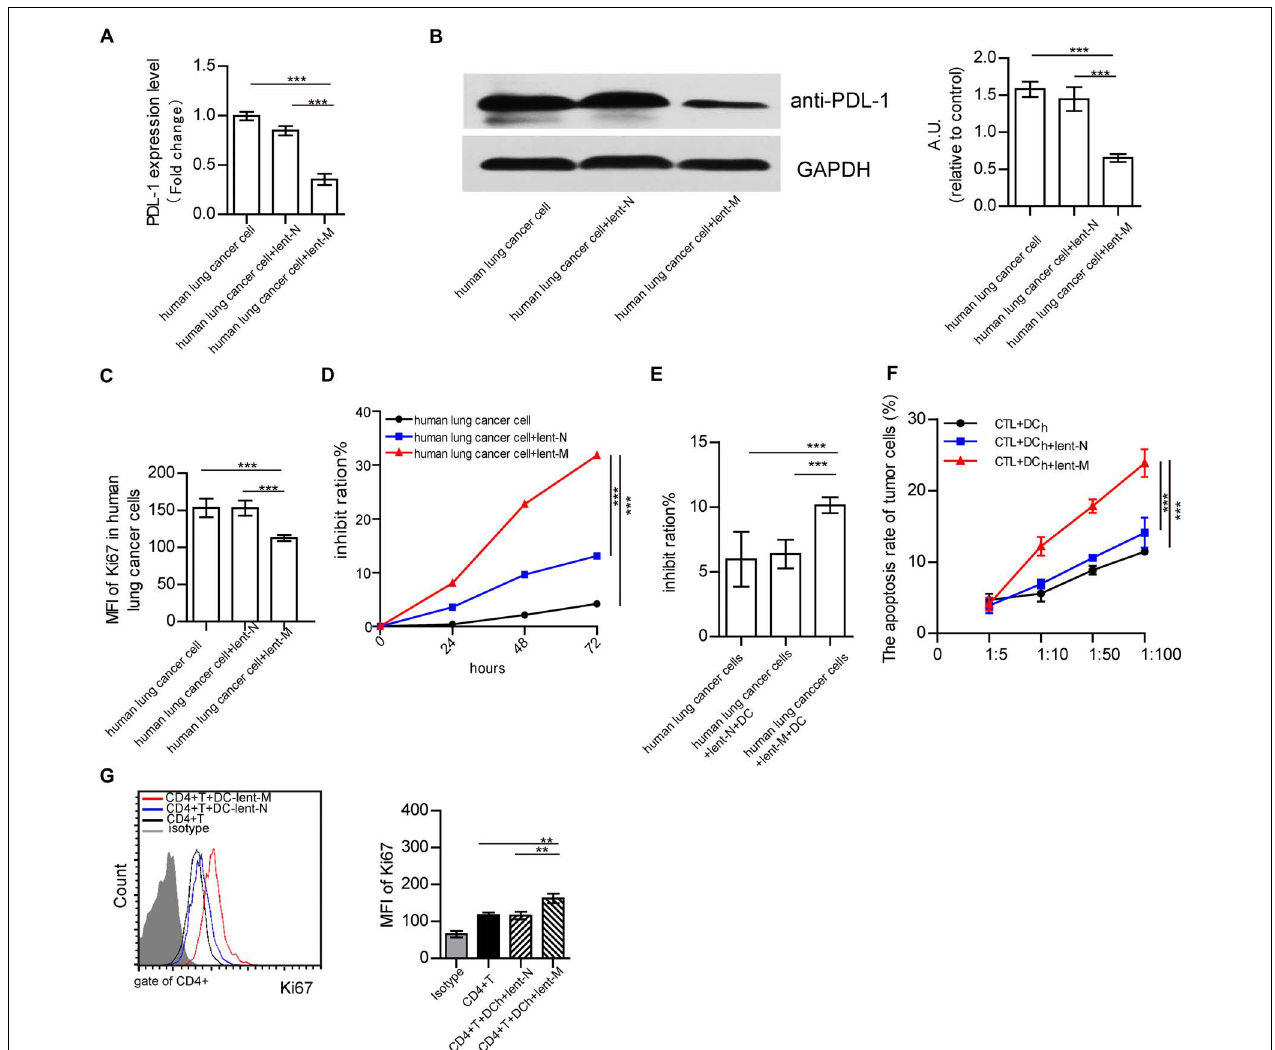
FIGURE 7 | Effects of lent-miR-138-5p on human NSCLC. After treatment with lent-miR-138-5p (Lent-M) or the corresponding negative control lentivirus (lent-N), PD-L1 expression on isolated human lung cancer cells was analyzed by qRT-PCR (A) or Western blot (B) . Upon lent-miR-138-5p (lent-M) or lent-N treatment, the proliferation of human NSCLC cells was analyzed by flow cytometry detection of Ki67 (C) and the inhibition rate of the proliferation of human NSCLC cells was analyzed by MTT assay (D) . (E) With lent-M, lent-N treatment, the inhibit ration of human DCs on isolated human lung cancer cells were analyzed. (F) Percentages of apoptotic tumor cells co-cultured with CD3 + CD8 + human T cells (CTL) activated by human DCs pretreated or not with lent- miR138-5p or lent-N treated A549 cells. (G) The proliferation of human CD4 + T cocultured with human DCs pretreated or not with lent- miR138 or lent-N treated A549 cells (Three independent assays were performed; ** P < 0.01, *** P <